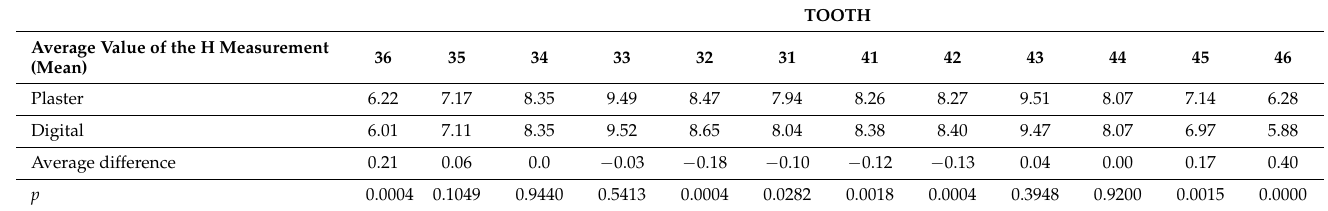
Table 4. Comparison of the mean values of the measurements of the height of the clinical crown (H) in the lower